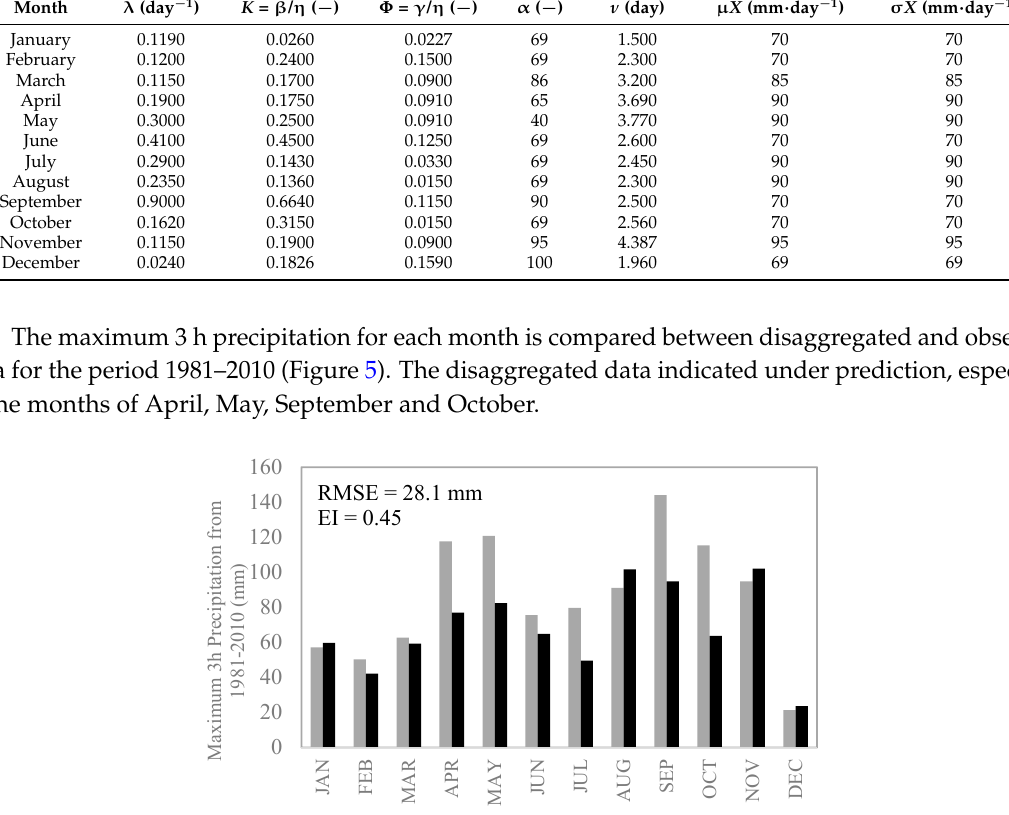
Figure 5. Comparison of maximum 3 h rainfall from 1981 to 2010 (Black: Disaggregated, Grey: Observed/Historical).